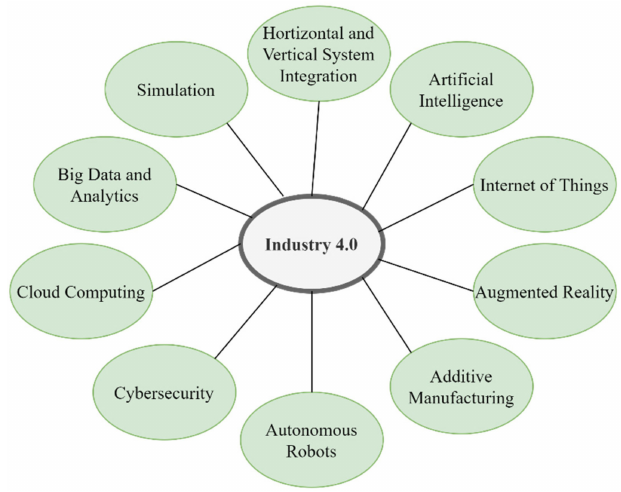
Figure 1. Industry 4.0